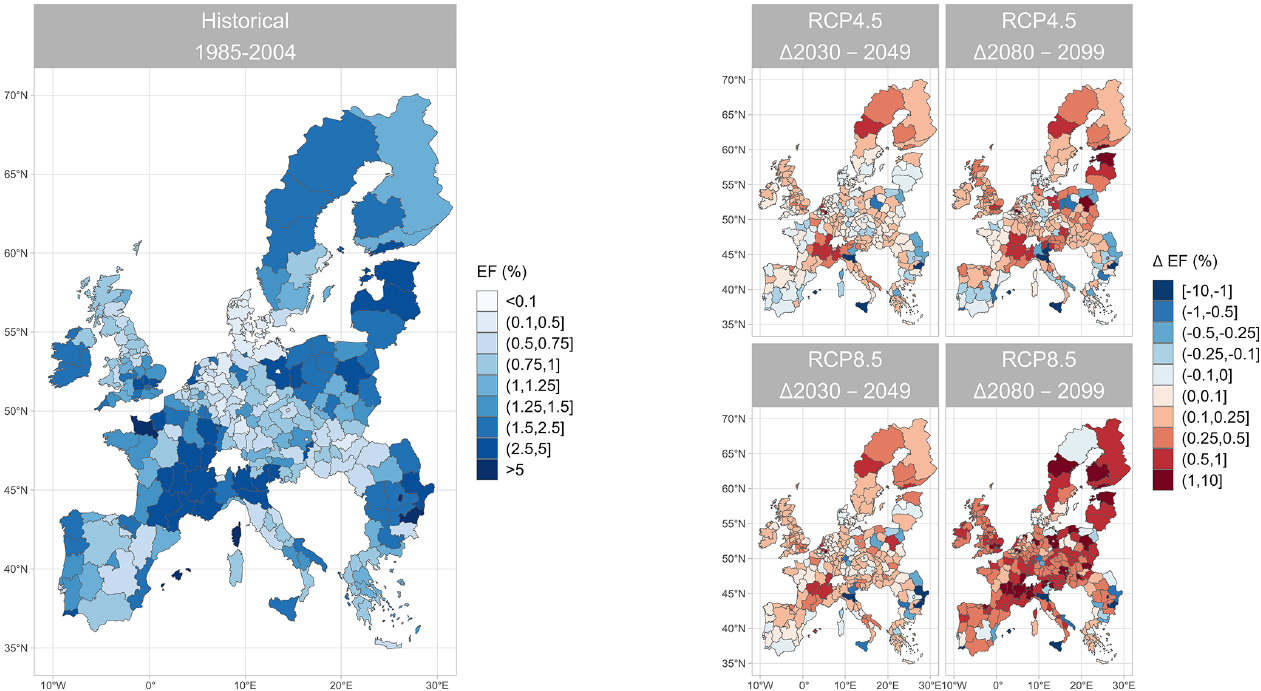
Figure 6. The N 2 O emission factor (EF%) for croplands and grasslands in European administrative regions (NUTS2). The EF is reported for the historical period (1985–2004) and the difference (cid:49) from the middle (2030–2049) and the end (2080–2099) of the century for the two climatic scenarios RCP4.5 and RCP8.5. The EF is calculated as the ratio between the N emitted as N 2 O from croplands (irrigable scenario) and grasslands and the N introduced into the system as fertiliser (not including the N added by animal excretion, crop residue, atmospheric deposition, soil mineralisation and fixation).